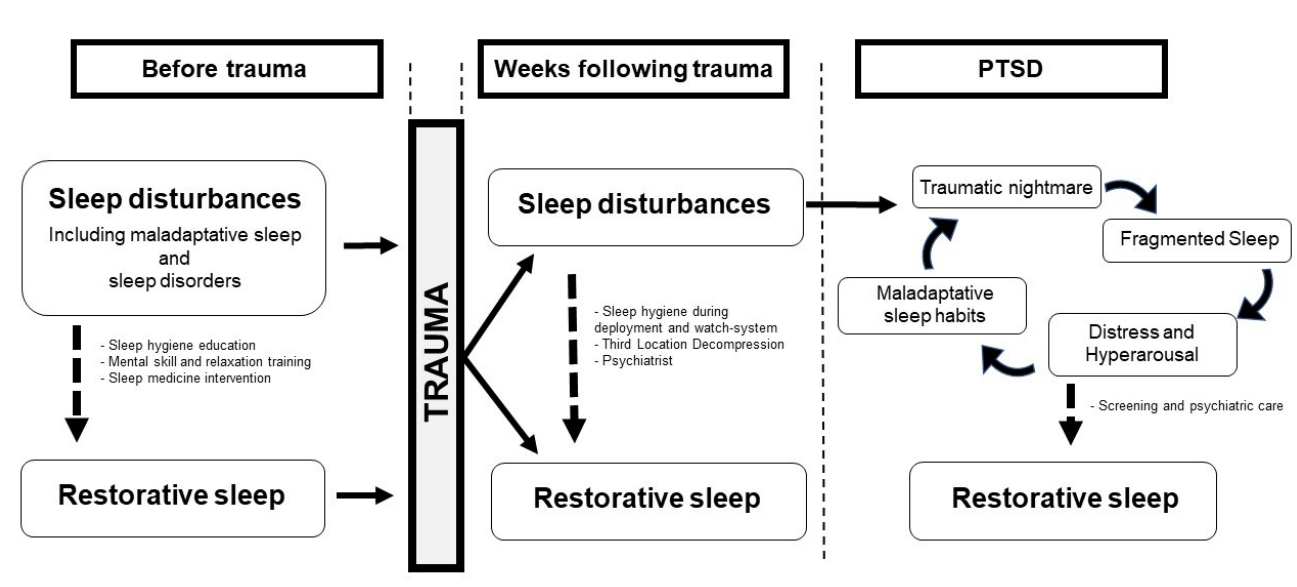
Figure 2. Sleep disturbances, PTSD and specific interventions in military.